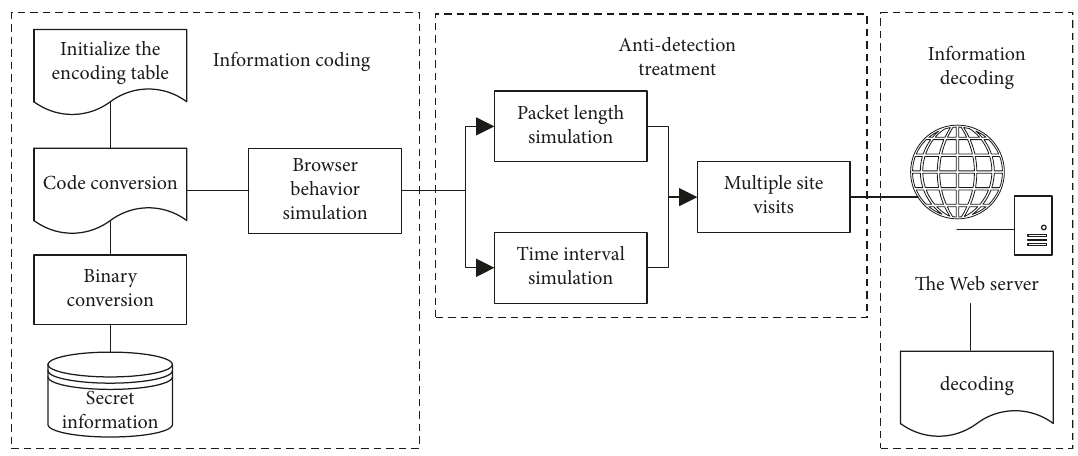
Figure 1: Basic principle framework of